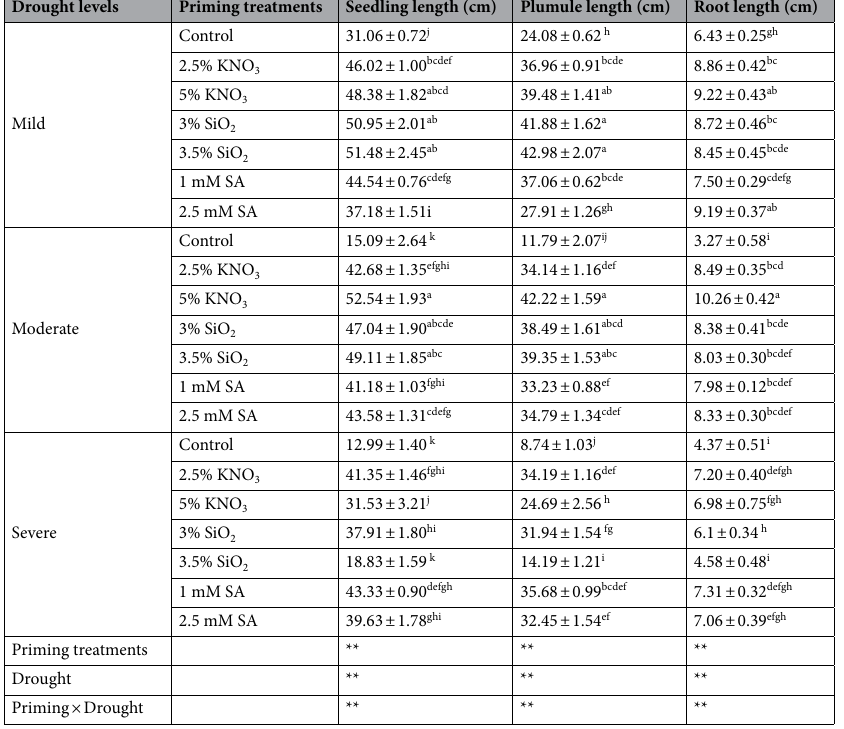
Table 2. Seedling growth performance of rice primed with KNO 3 , SiO 2 and SA under drought conditions. Mean values ± SE in the same column followed with similar letters are not significantly different according to DMRT ( P ≤ 0.05); SE Standard error of the mean, *Significant at 5% level of probability, **Significant at 1% level of probability, ns Not